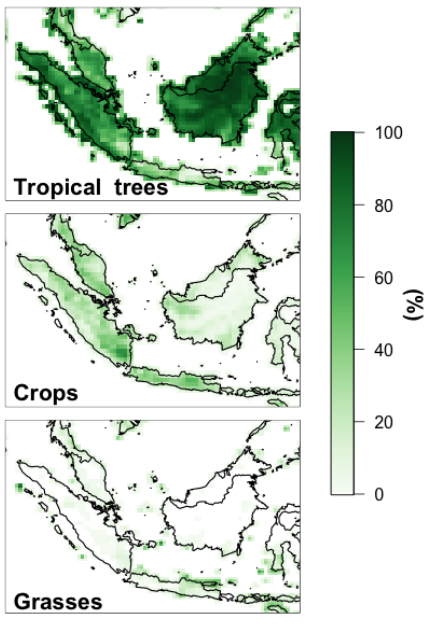
etation classes in the No Palm scenario at the native 0.23 ◦ × 0.31 ◦